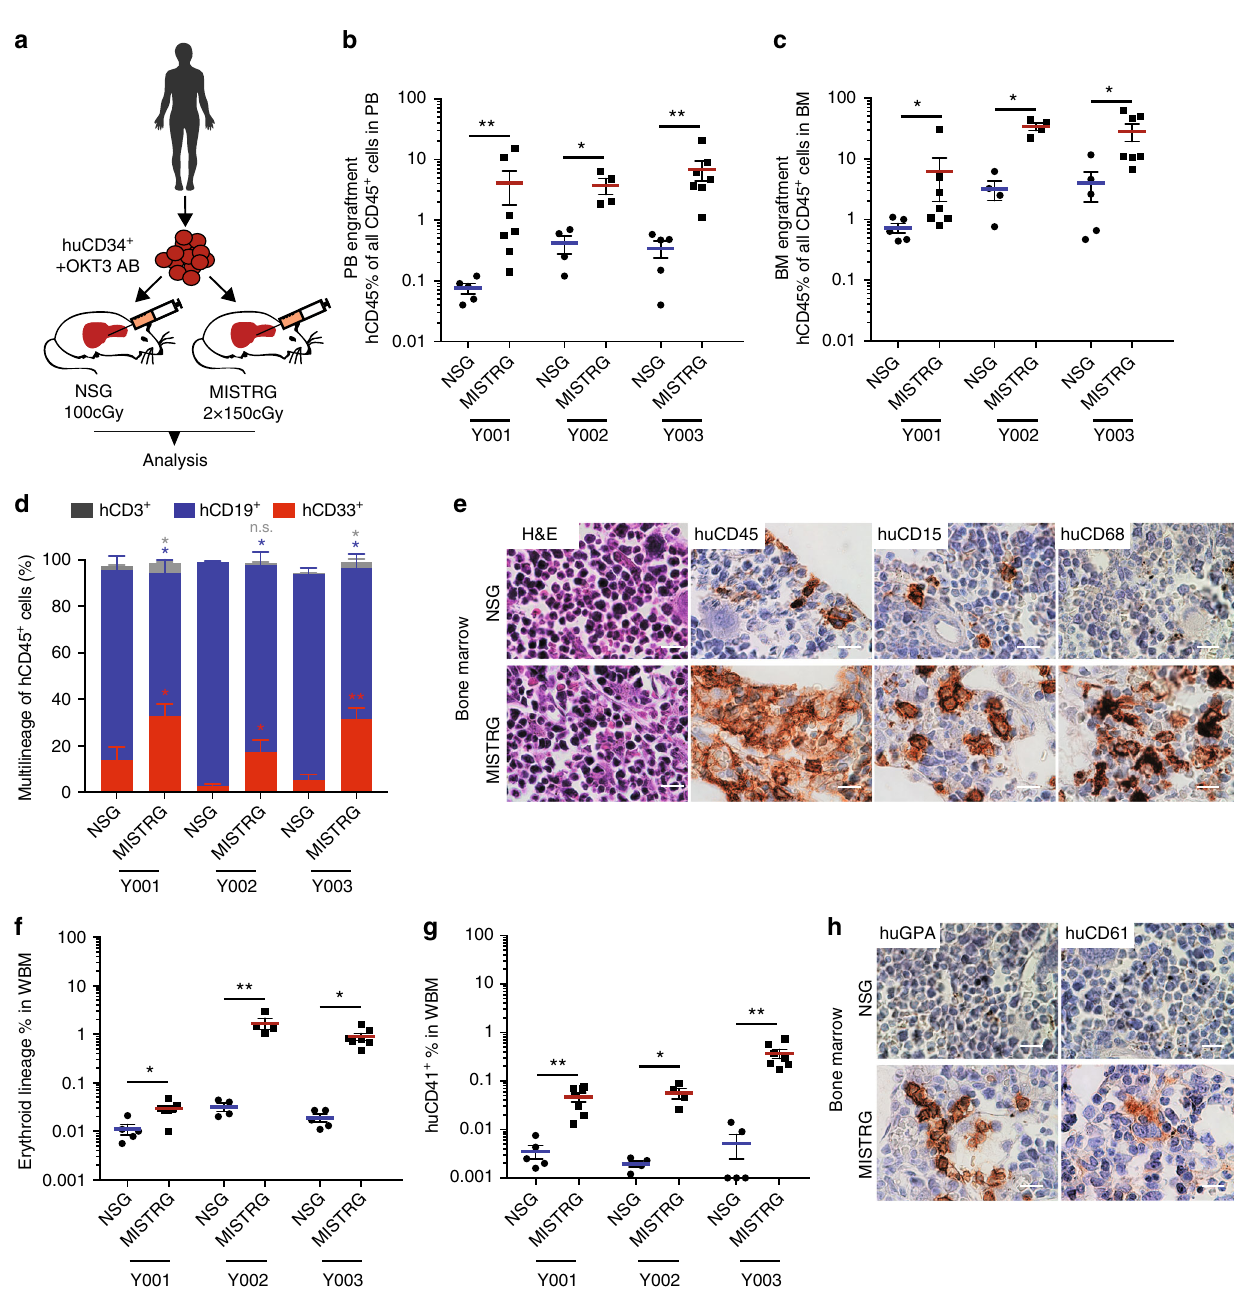
Fig. 1 Enhanced engraftment of adult healthy bone marrow (BM)-derived CD34 + hematopoietic stem and progenitor cells (HSPCs) in human cytokine- knockin MISTRG mice. a Universal experimental setup. Human BM-derived CD34 + HSPCs were pre-incubated with anti-CD3 antibody (OKT3) and injected intrahepatically into newborn (D2 – 3) NSG or MISTRG mice conditioned with the respective maximum tolerated irradiation doses (NSG 100 cGy, MISTRG 2 × 150 cGy). Mice were analyzed 10 – 17 (healthy BM), 13 – 30 (myelodysplastic syndrome (MDS)), and 9 − 24 (acute myeloid leukemia (AML)) weeks post transplantation. b , c Comparison of overall human CD45 + engraftment in peripheral blood (PB) and BM in NSG versus MISTRG mice. Individual mice are represented by symbols. d Relative distribution of myeloid CD33 + (red), B-lymphoid CD19 + (blue), and T-lymphoid CD3 + (gray) cells as % of human CD45 + cells in NSG vs. MISTRG mice. e BM histology of representative NSG and MISTRG mice from ( d ). Hematoxylin and eosin (H&E) and immunohistochemistry (IHC) stains for huCD45, huCD15, huCD68 in NSG (top) and MISTRG BM (bottom row) (scale bars 10 µ m, original magni fi cation 60×). f , g Comparison of erythroid and megakaryocytic lineage engraftment in BM of NSG and MISTRG mice. h BM histology of representative NSG and MISTRG mice from ( d ). H&E and IHC stains for huCD235 and huCD61 as in ( e ). For detailed sample information see Supplementary Table 1. In ( c , d , e , f , g ) data are represented as means ± S.E.M.; Mann – Whitney test: n.s. not signi fi cant, * p < 0.05, ** p < 0.01 MISTRG. The engraftment persisted until the time of analysis, (top row) and bone marrow (bottom row) (Fig. 2a – c). Only 2 out >12 weeks post transplantation, without development of of 29 samples (MDS with multi-lineage dysplasia (MLD) Y006, compromising anemia or thrombocytopenia in recipient mice MDS with excess blasts 2 (EB-2) Y018), injected at <1 × 10 5 (Supplementary Figure 3a-c) or differences in survival between CD34 + cells/mouse displayed BM engraftment levels <1% in NATURE COMMUNICATIONS| (2019) 10:366